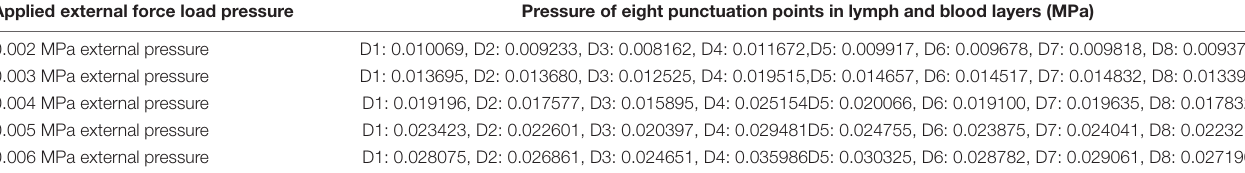
TABLE 5 | Eight-point-specific pressure table of lymph and blood layers of the forearm model with different external force pressure values. Applied external force load pressure Pressure of eight punctuation points in lymph and blood layers